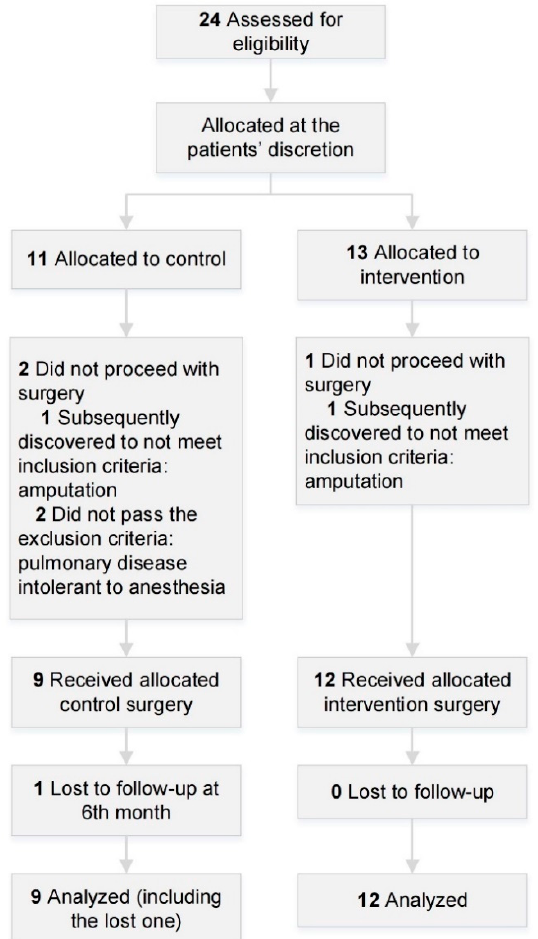
Figure 1. Flow of participants in the study of preoperative planning using 3D-multimodality imaging for soft tissue sarcoma of the axilla.